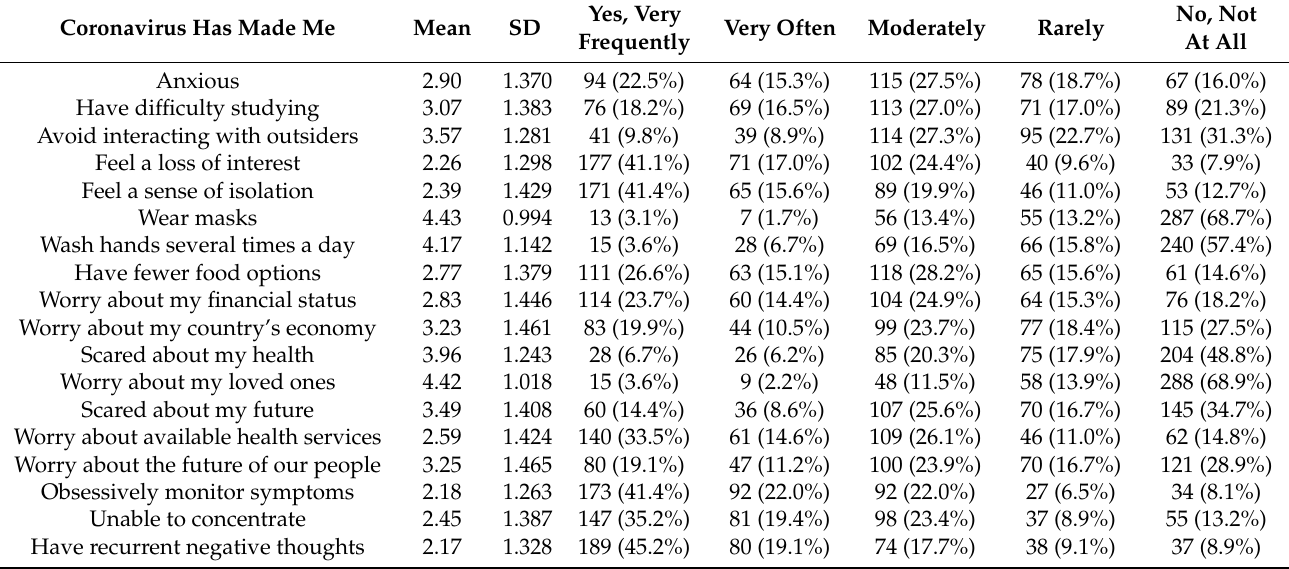
Table 2. Feelings related to the coronavirus disease outbreak in the participants ( n =